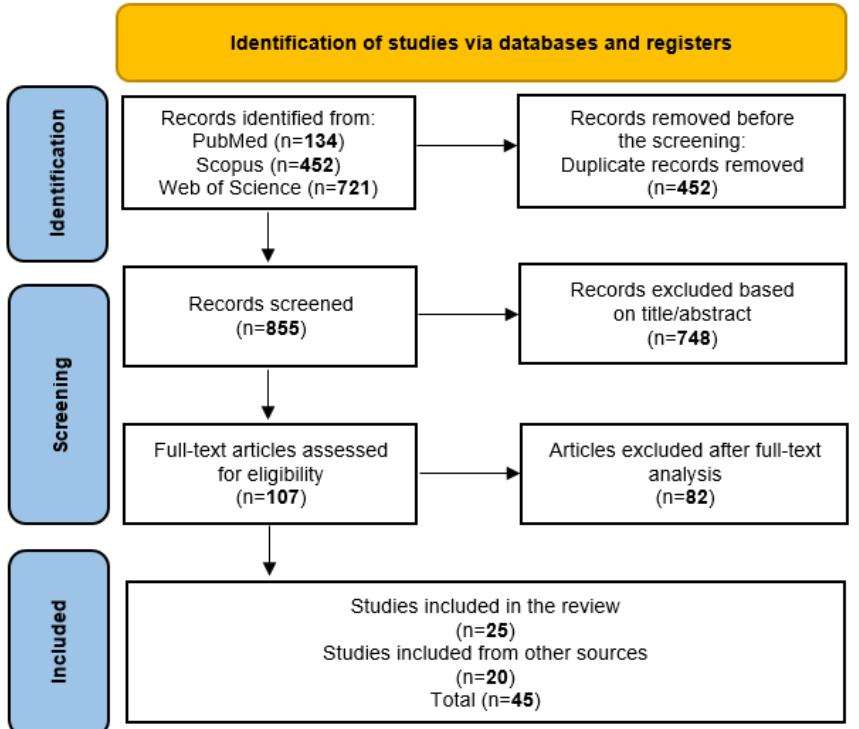
Figure 1. PRISMA fl owchart illustrating the identi fi cation of studies for